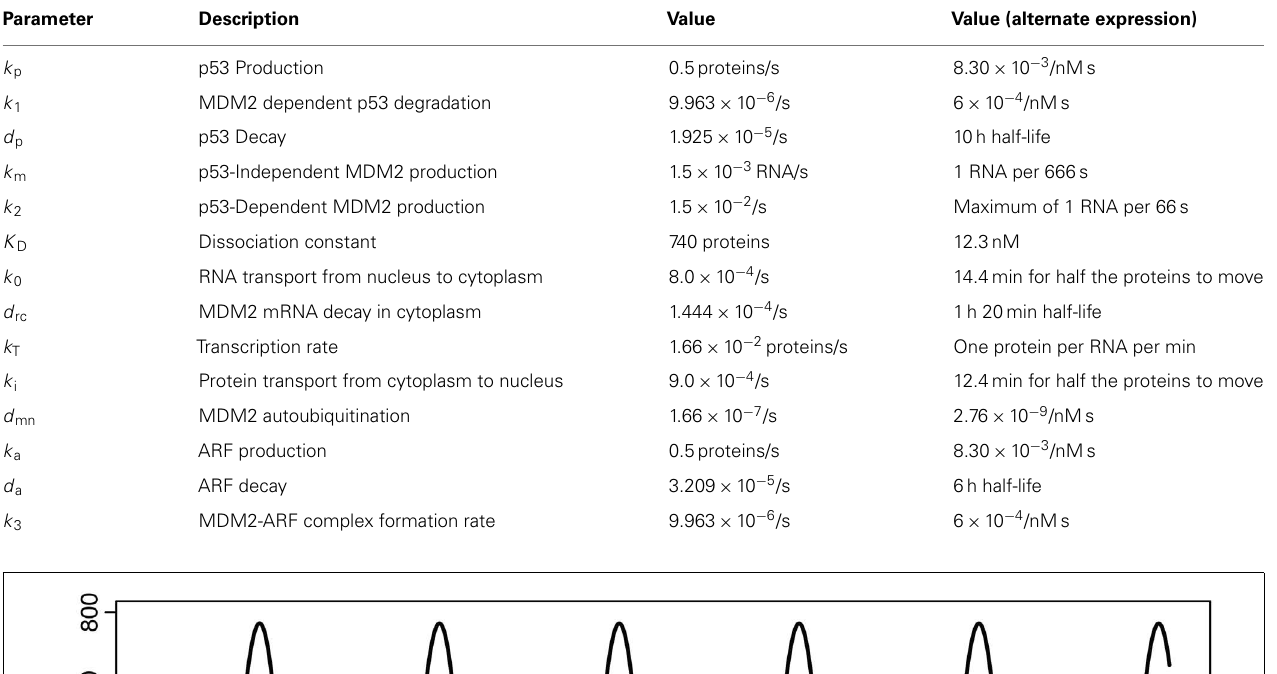
Table 2 | Parameters used in the model.